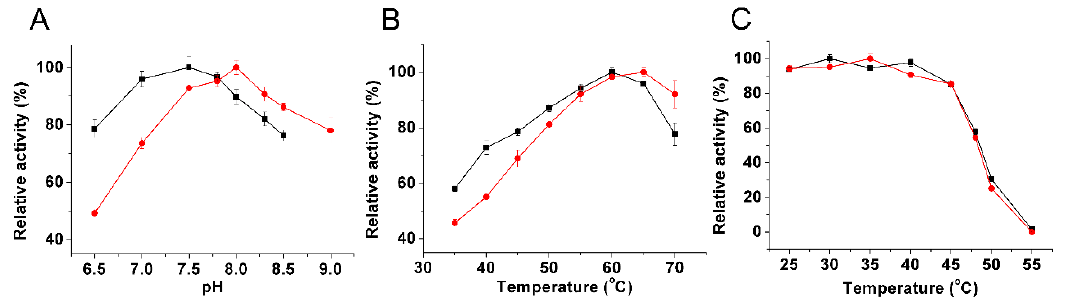
Figure 5. Effect of pH and temperature on the activity of Bl IDH in the presence of Mg 2+ ( ● ) and Mn 2+ ( ■ ), respectively. ( A ) Effect of pH on the activity of Bl IDH; ( B ) Effect of temperature on the activity of Bl IDH; ( C ) Heat-inactivation profiles of the Bl IDH. The values indicate the means of at least three independent measurements.